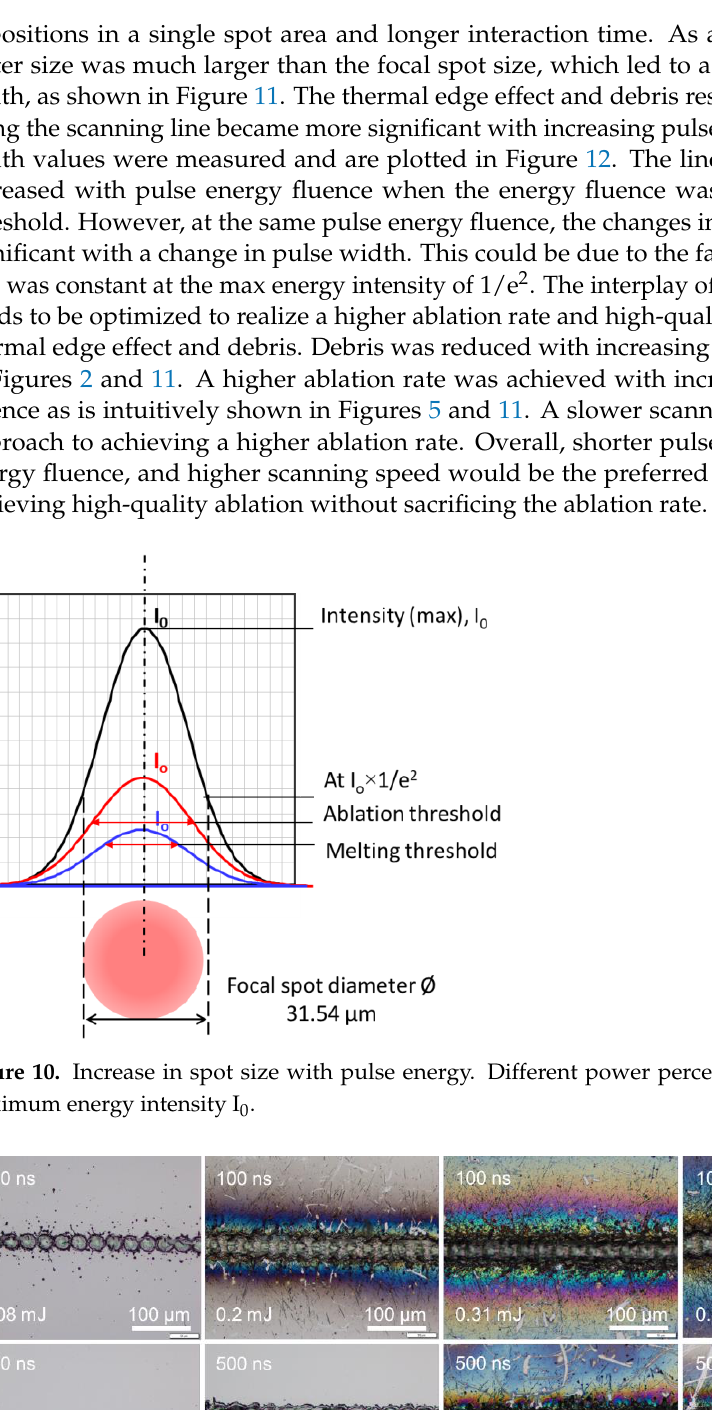
Figure 12. Scanning line width versus pulse energy fluence, showing that there are no significant changes with pulse width at energy fluences far beyond the ablation threshold. 4. Conclusions An investigation of surface ablation and melting energy threshold dependency on pulse width in the ns NIR laser scanning of silicon has been carried out. The surface abla- tion threshold and melting threshold in the laser scanning of silicon were significantly